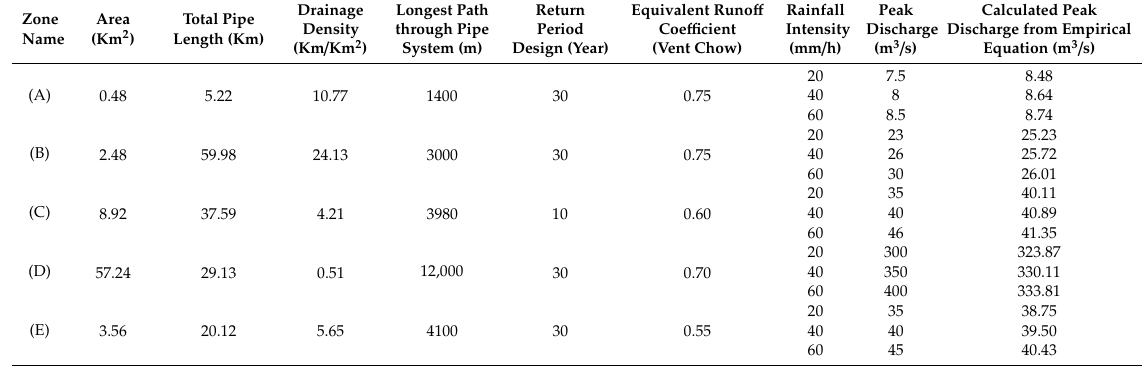
Table 4. Data of validation catchments [39].